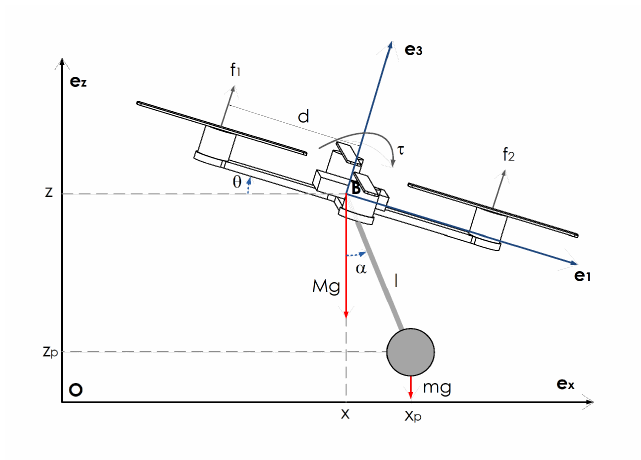
Figure 4. Two-dimensional quadrotor with a cable-suspended